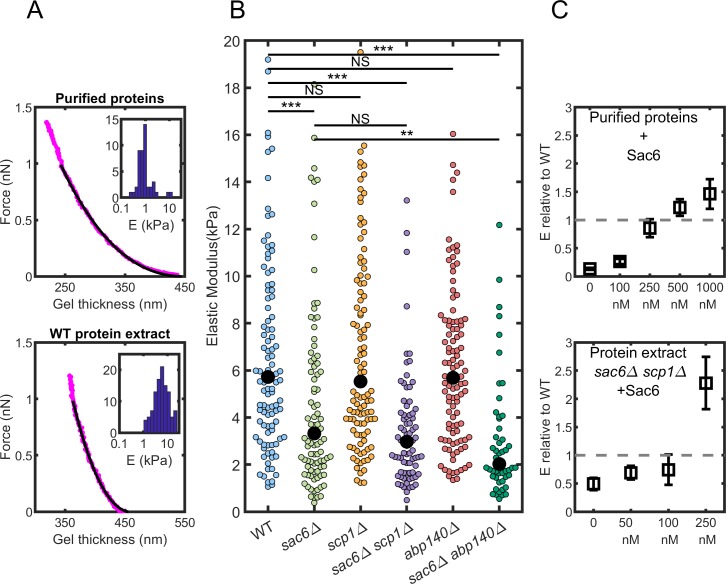
Elastic properties of reconstituted actin networks.The underlying data can be found within S3 Data. (A) Principle of the measure. Force-distance curves obtained on an actin network and distribution of the elastic moduli extracted from many force-distance curves (inset). Gels are assembled from a mix of purified proteins (top, 46 gels) or from WT protein extracts (bottom, 107 gels). (B) Elastic moduli of the actin gels assembled from protein extracts. Colored symbols are individual measurements; black dots are the median values. (C) Effect of the addition of purified Sac6 on the elastic modulus. Elastic moduli normalized by the elastic modulus of WT protein extract when Sac6 is added to mix of purified proteins (top) or sac6Δ scp1Δ protein extract (bottom). Error bar calculation is described in the Materials and methods section. Abp140, actin-binding protein 140; NS, not significant; Sac6, yeast homolog of fimbrin; Scp1, yeast homolog of calponin; WT, wild type.